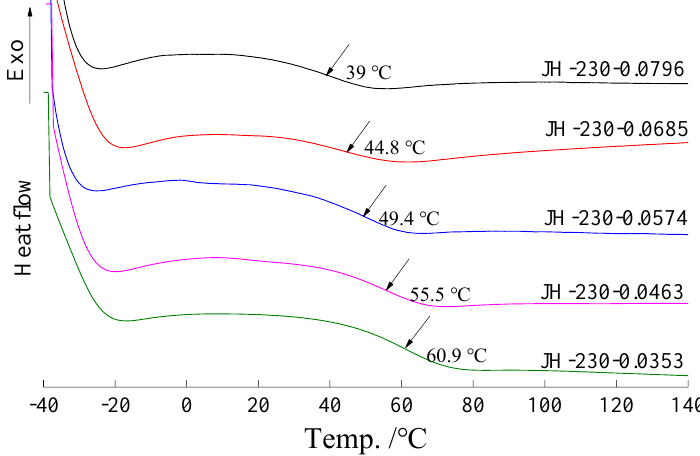
Figure 8. The second heating DSC curves of the SM-HEP-AM (heating flow = 10 °C/min).